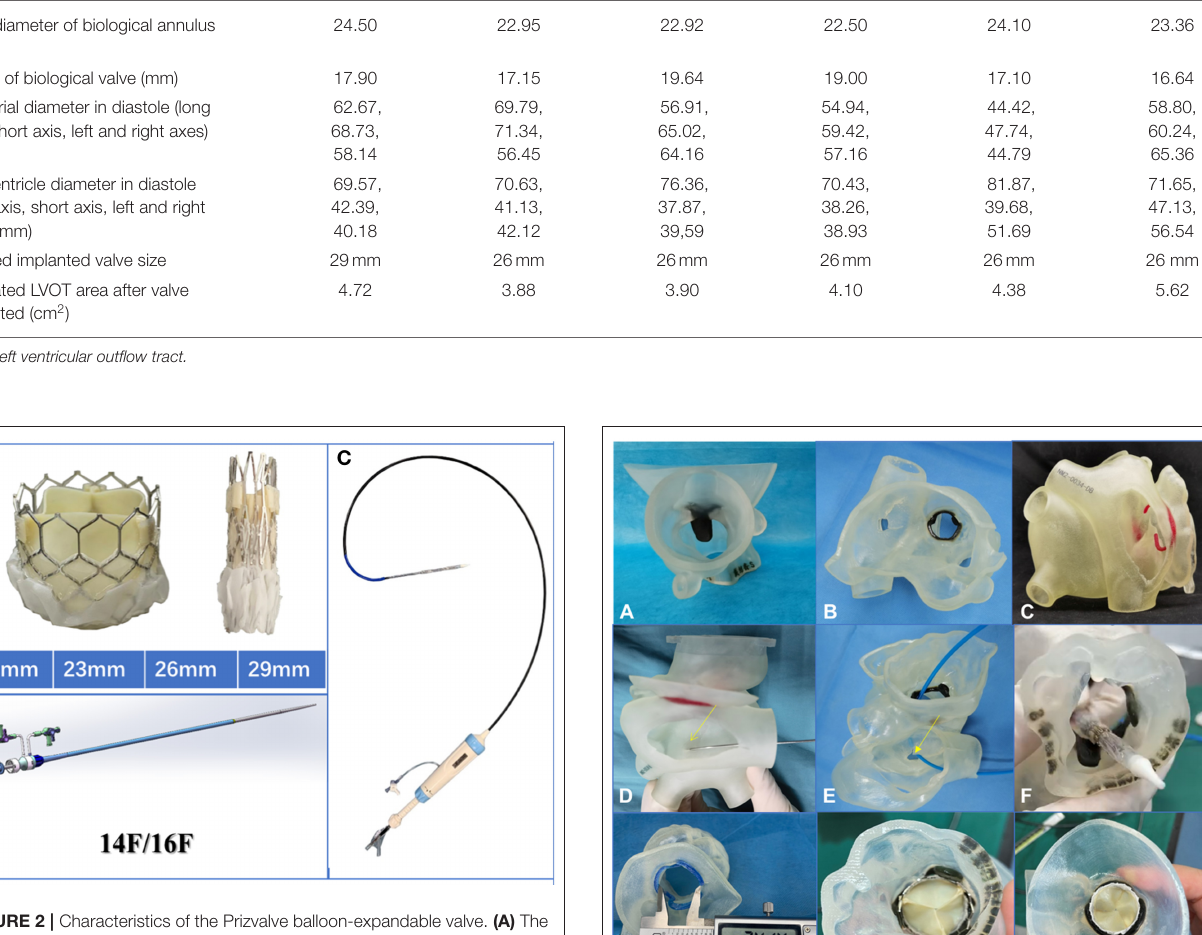
TABLE 3 | Preprocedural evaluations of patients undergoing transcatheter mitral valve implantation. Patient number